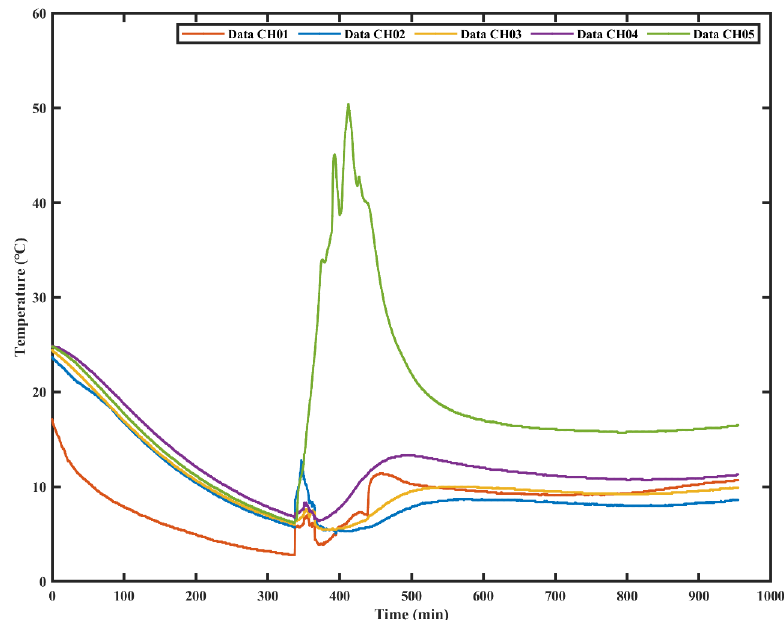
Figure 12. Temperature vs. time curves of sensor nodes in incubator.